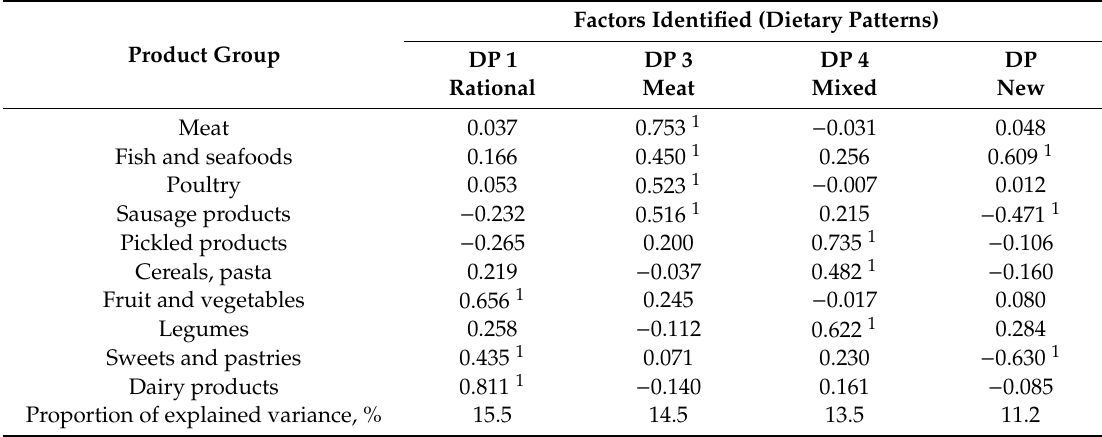
Table A13. Factor loadings of the principal dietary patterns identified (Kemerovo region).